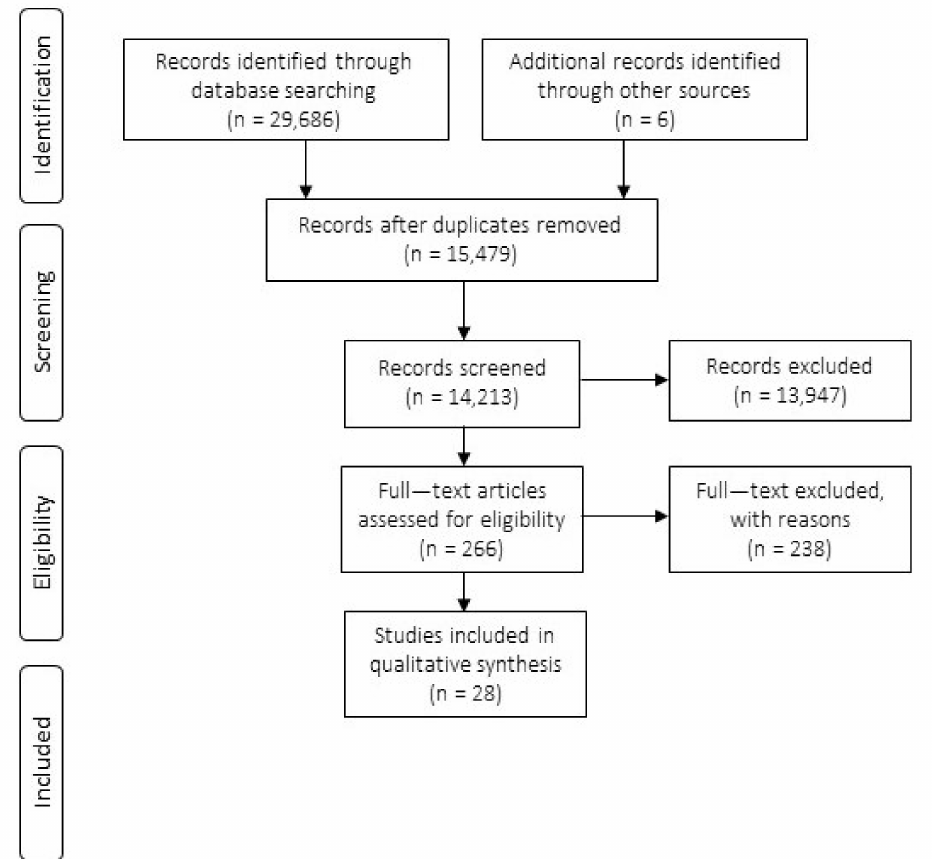
Figure 1. Prisma flowchart to show study selection process